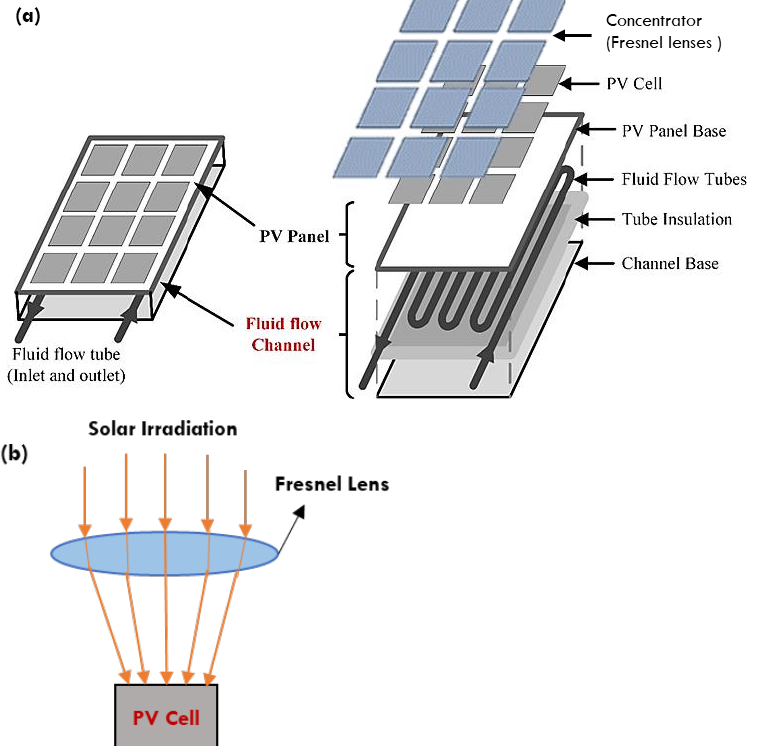
Figure 3. Schematic illustration of ( a ) the intended nanofluid operated PV/T system, ( b ) concentrated solar irradiations on the surface of each PV cell.